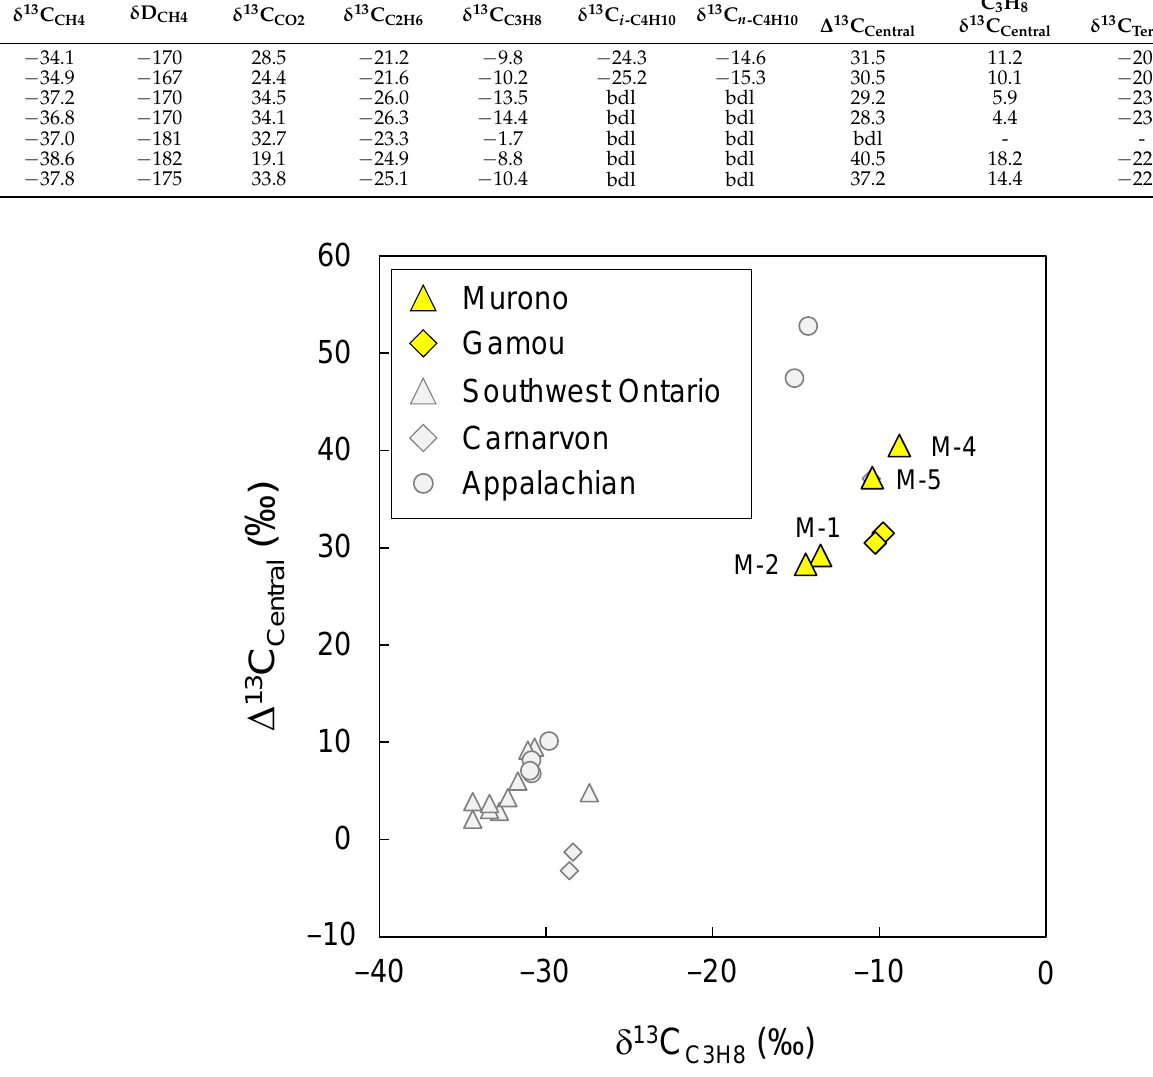
Figure 4. Relative 13 C-enrichment on the central position ( ∆ 13 C Central ) versus bulk isotope compo- sition ( δ 13 C C3H8 ) of propane from Tokamachi mud volcano area (Murono and Gamou). Error bars are within the symbol. Gray symbols are samples from previous studies including samples from the Appalachian Basin (USA), Southwest Ontario (Canada) and Carnarvon (Australia) [19,23]. Sample numbers for Murono are